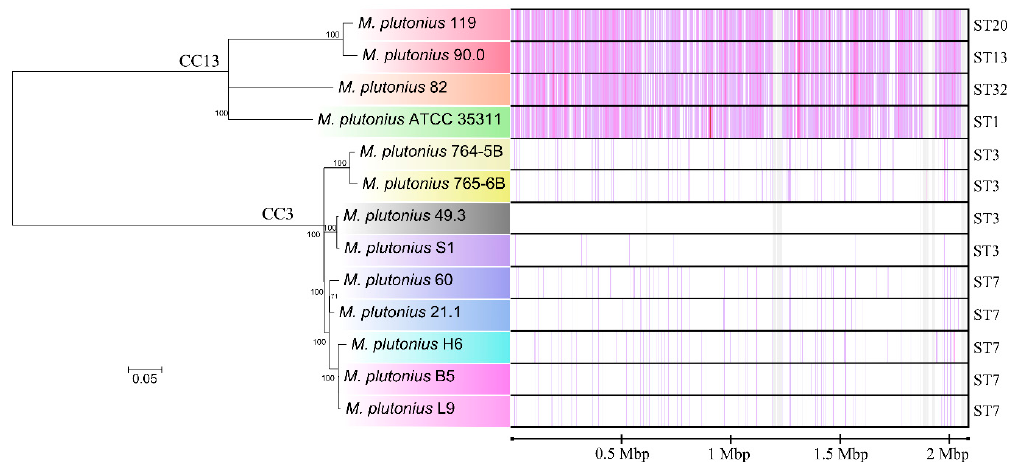
Figure 3. Phylogenetic tree based on core genome single nucleotide polymorphism (SNP)-typing of typical M. plutonius strains. The phylogenetic tree was obtained via the Harvest software suite [33]. M. plutonius 49.3 was set as the reference strain. The strains are marked in the same color code used in Figure 2. The SNP and Indel positions, in relation to the reference, are shown on the right hand side as violet lines. Sequence types are shown as well for comparison purposes.